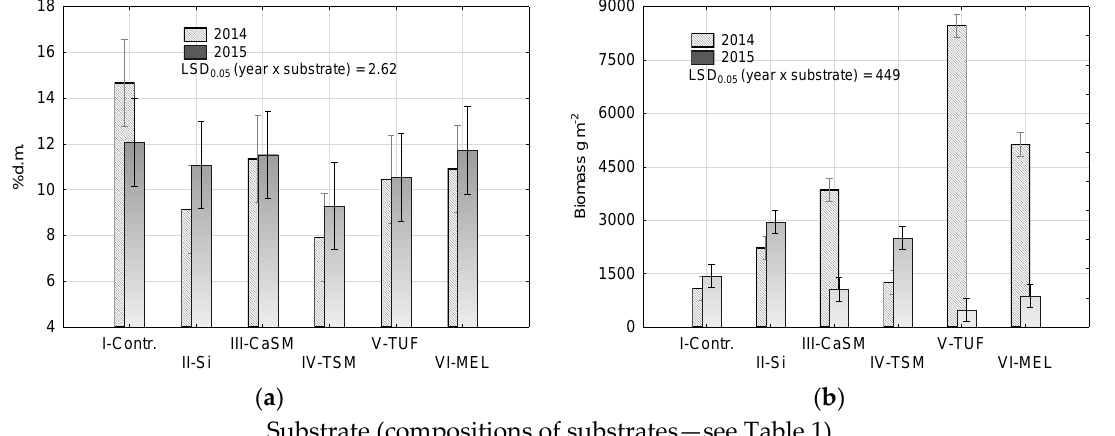
Figure 4. Dry matter (%) ( a ) and biomass (g m −2 ) ( b ) of Sedum acre L. grown in six green roof substrates.